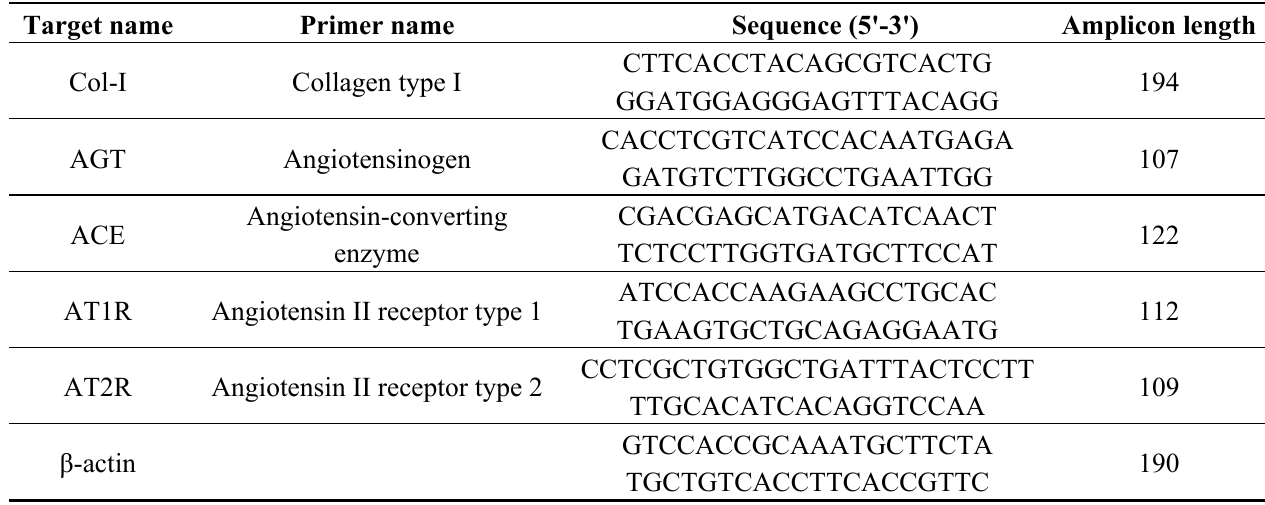
Table 1. Gene-specific primers designed for Col-I, AGT, ACE, AT1R, AT2R and β